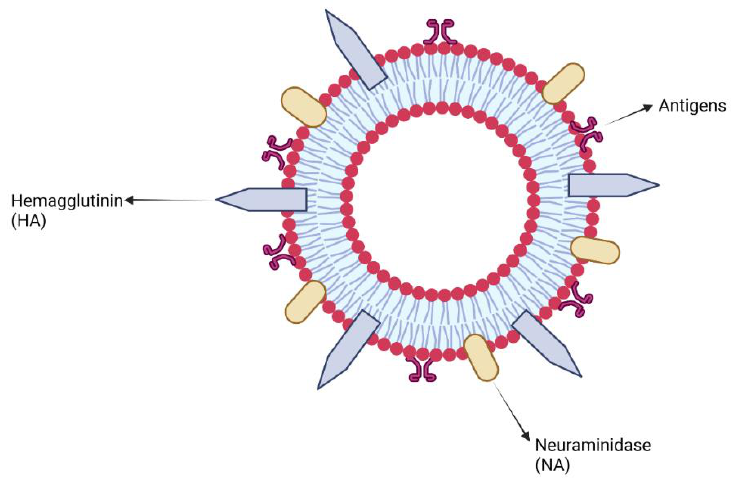
Figure 5. Schematic virosome adjuvant. Virosomes are synthesised from a phospholipid bilayer (similar to that of a liposome) where approved influenza vaccines are used the virosomes virus structure allowing for conjugation with influenza surface protein hemagglutinin (HA) and neu- raminidase (NA).